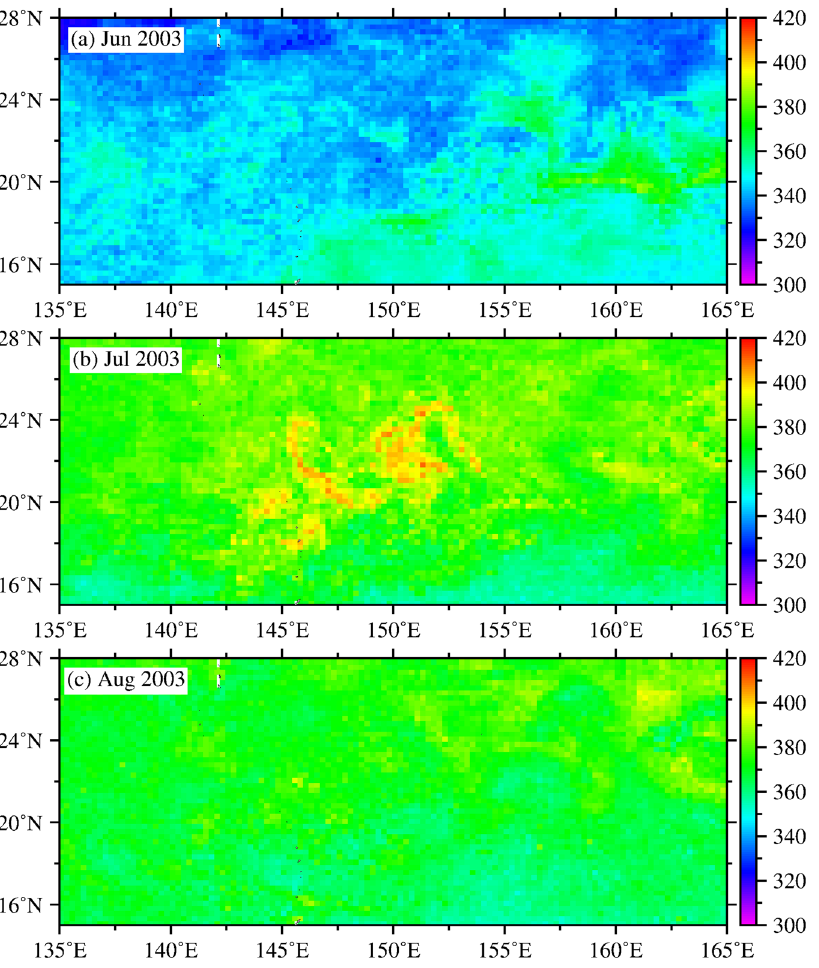
Figure 5. Surface water p CO 2 concentrations (ppm) before (June), during (July), and after (August) the